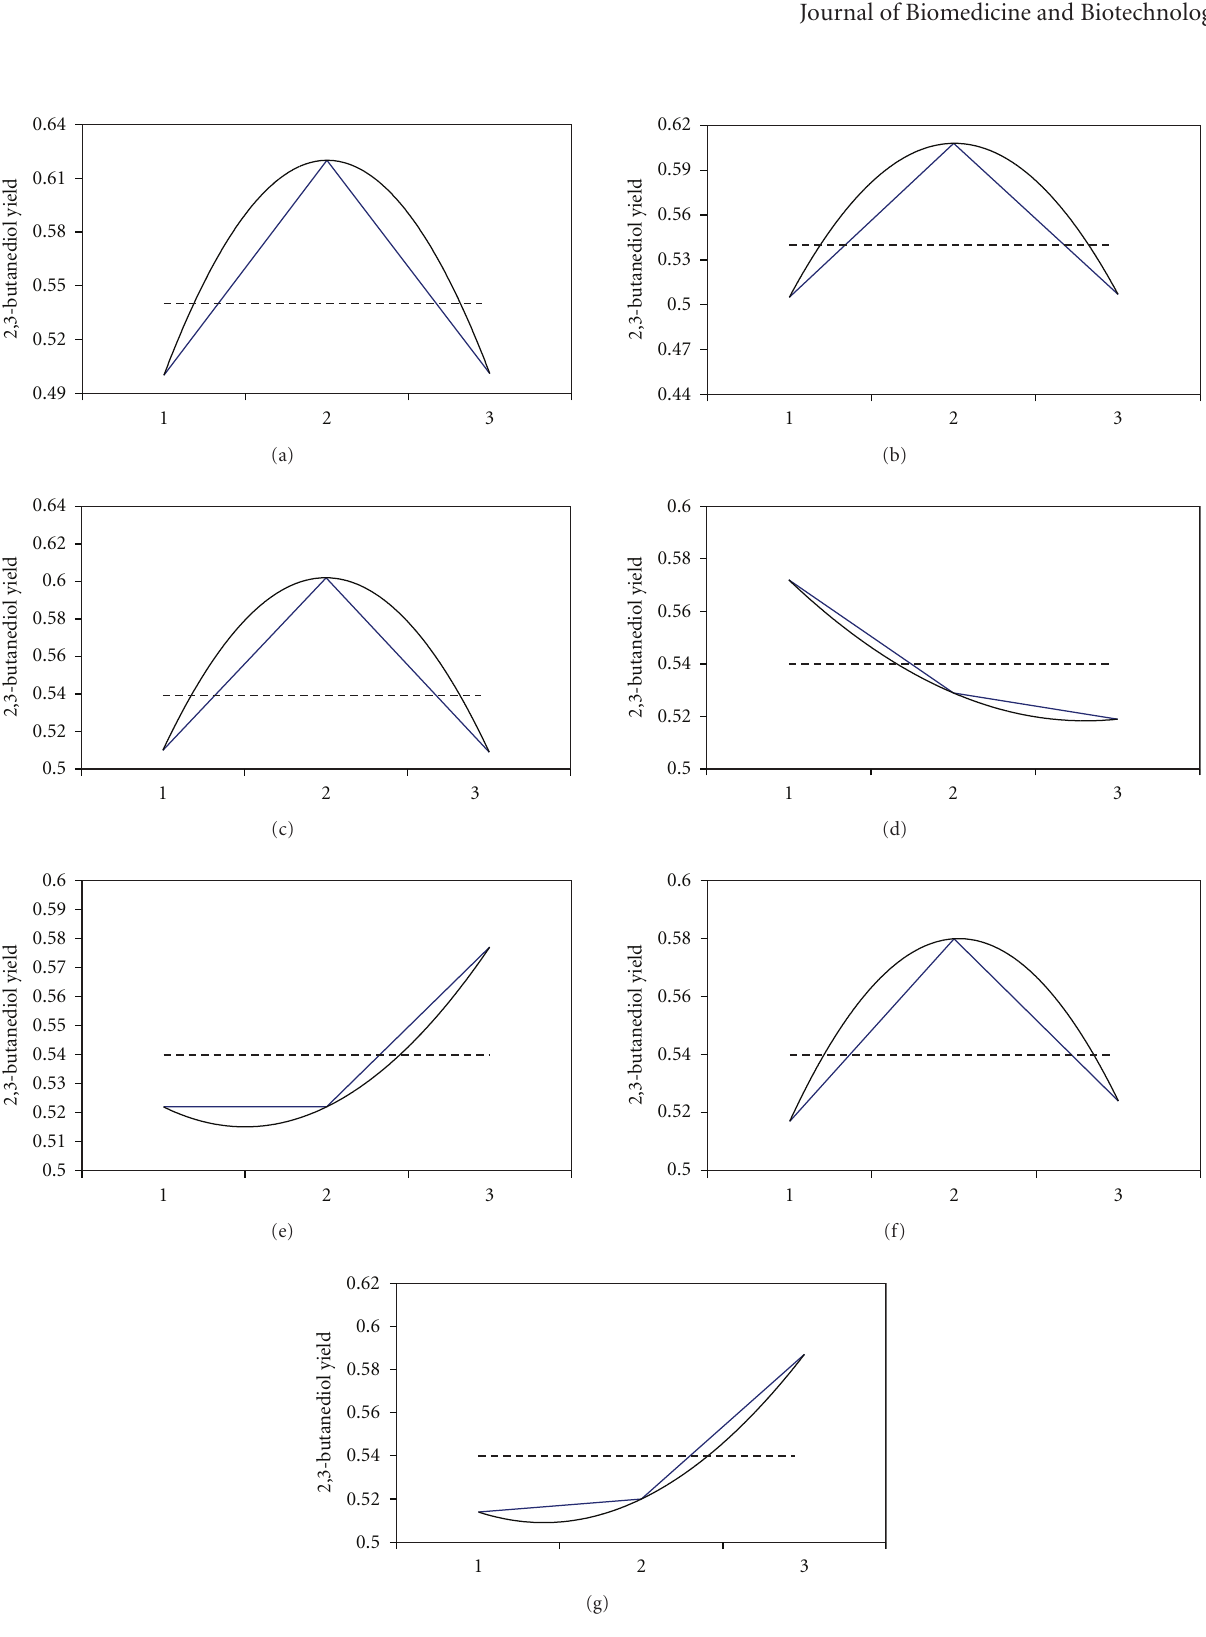
Figure 1: Impact of selected fermentation-factor-assigned level on 2,3-butanediol yield by K. oxytoca . Impact of selected-factor-assigned levels on 2,3-butanediol yield by K. oxytoca. X -axis represents assigned levels of selected factor and Y -axis represents 2,3-butanediol yield. (a) Glucose, (b) acetic acid, (c) succinic acid, (d) pH, (e) temperature, (f) mixing intensity, and (g) inoculum size G (- --) indicates average 2,3-butanediol yield during experimentation and (—)indicates individual factors contribution 2,3-butanediol yield during